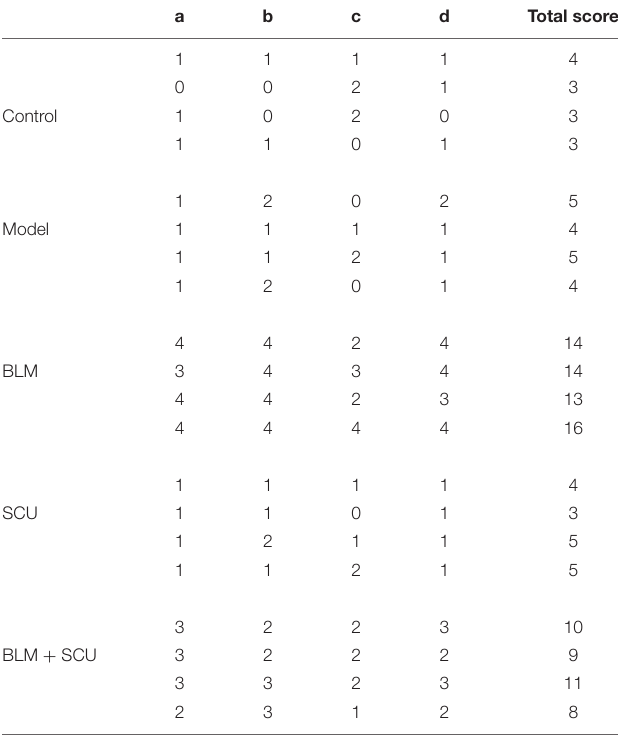
TABLE 2 | The lung injury scores of all samples ( n =